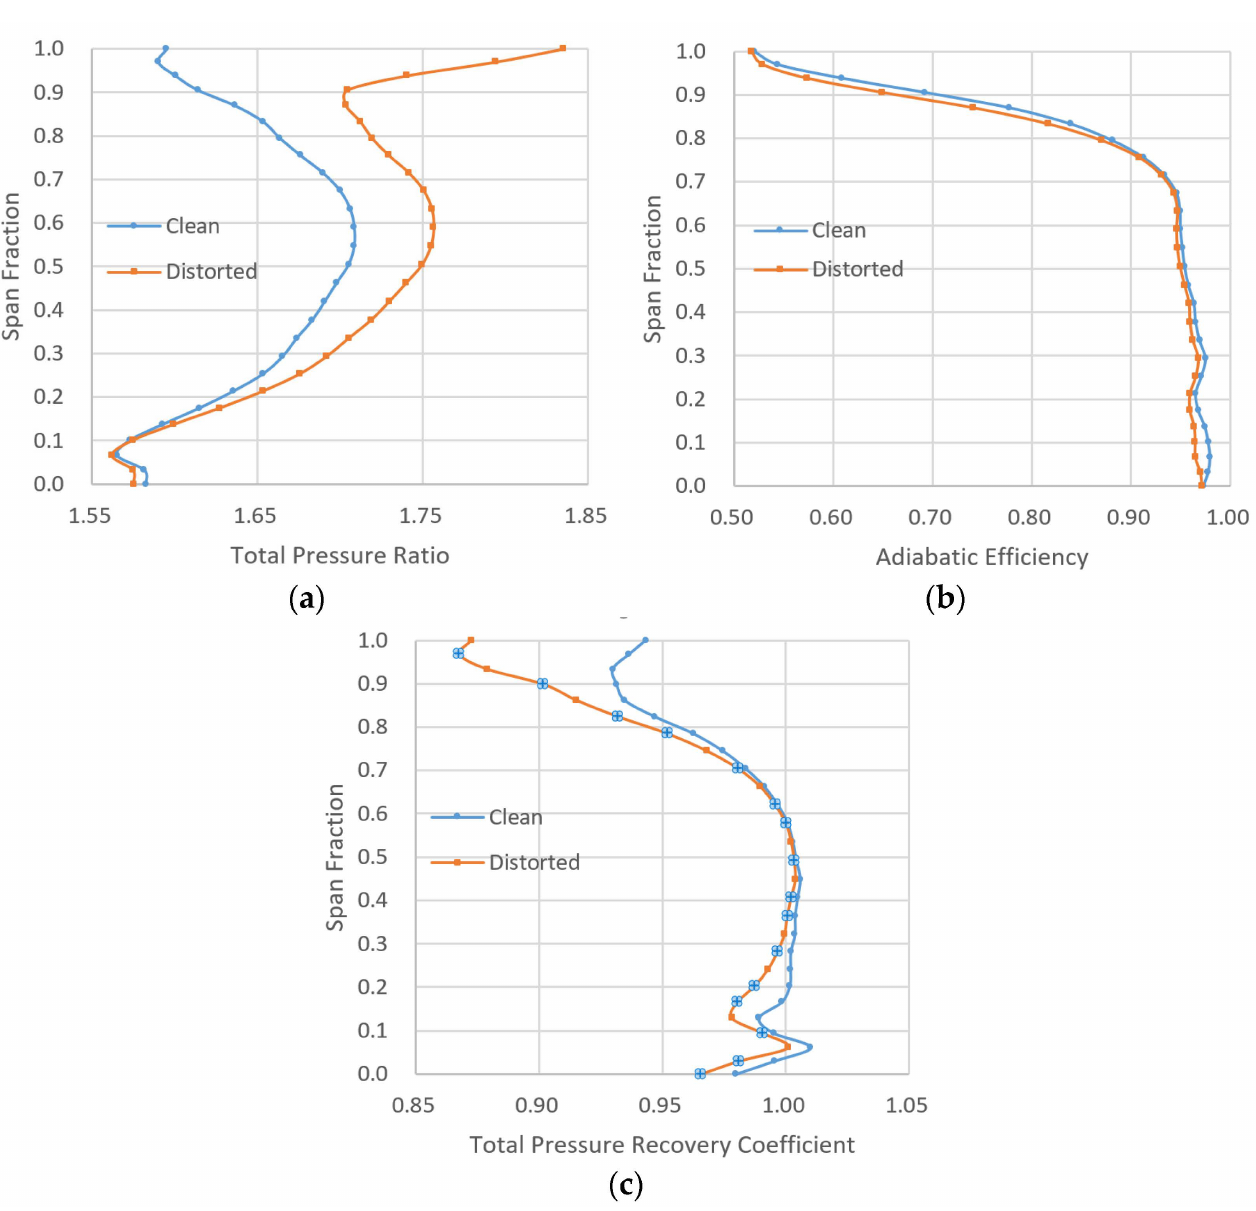
Figure 19. Clean vs. distorted span-wise distribution of the 11D’s parameters: ( a ) total pressure ratio of rotor; ( b ) adiabatic efficiency of rotor; ( c ) total pressure recovery coefficient of